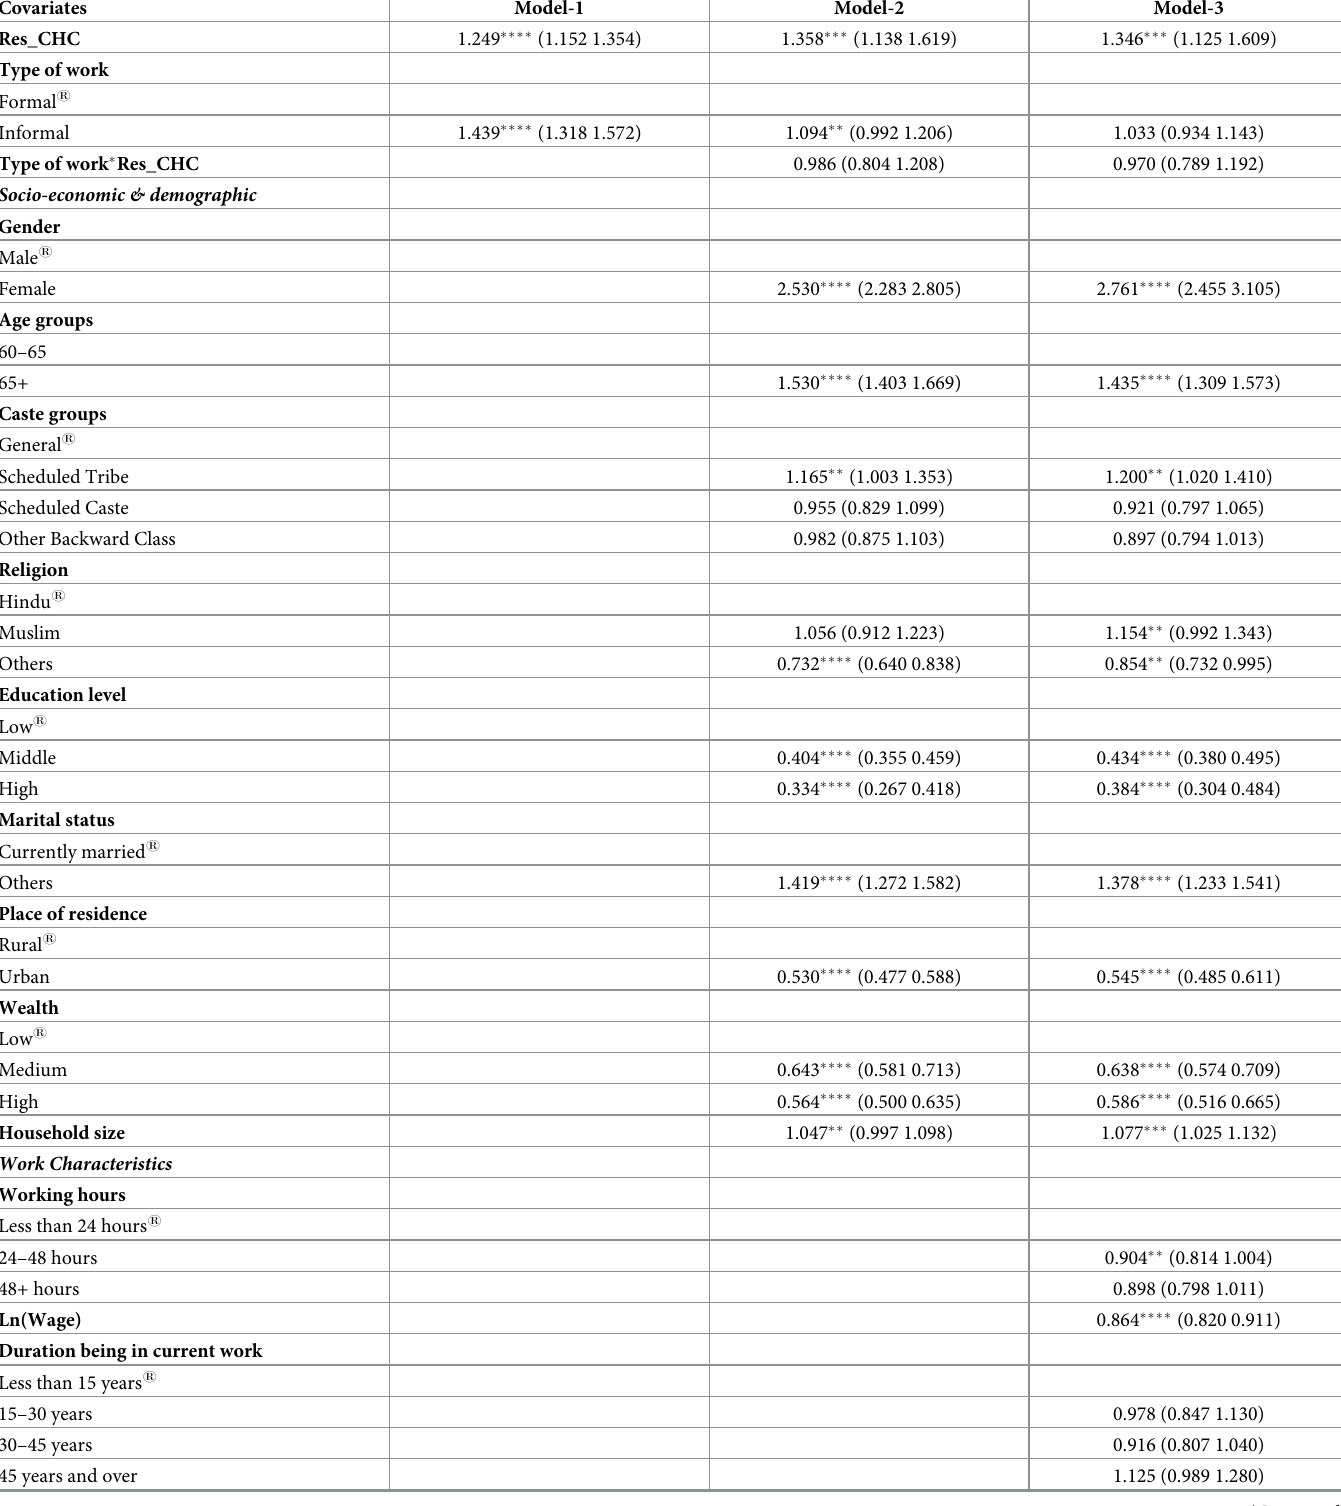
Table 7. Odds of multiple logistic regression for PCF and/or